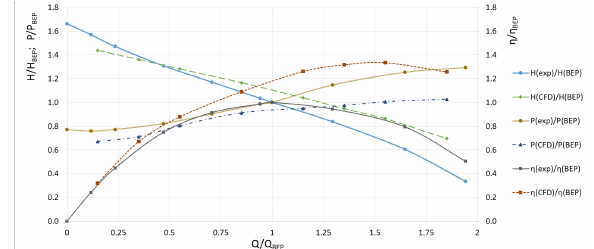
Figure 4: The comparison of the experimental and the numerical results